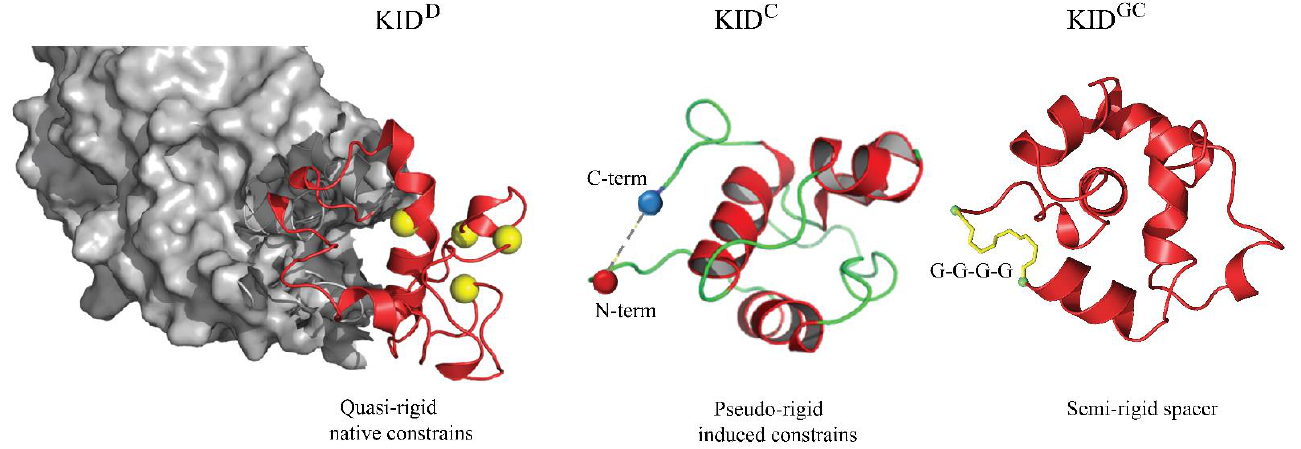
Figure 1. Kinase insert domain (KID) of RTK KIT as a domain fused to TKD (KID D ), a cleaved isolated polypeptide (KID C ) and a generic cyclic entity (KID GC ). 3D structures are taken as randomly chosen conformations from the MD simulation of each species, with KID shown as a red cartoon, TKD as the grey surface, and the motif representing GGGG being yellow sticks. TKD is shown partially with a focus on the region adjacent to KID.